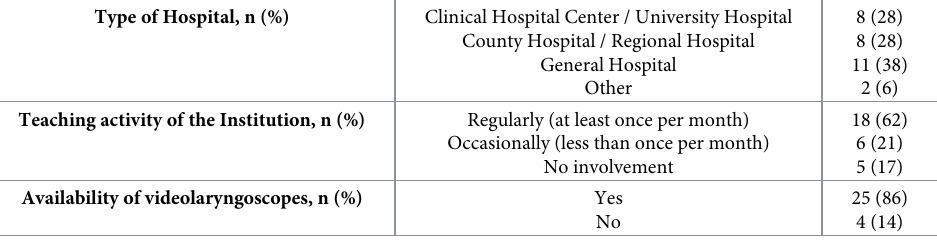
Table 1. Characteristics of all the responding institutions (n =